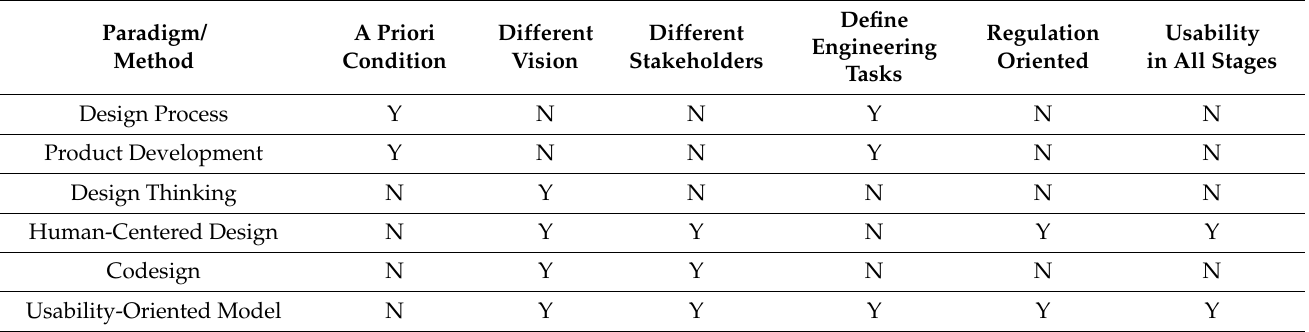
Table 6. Overview of the comparison between the usability-oriented model and the presented paradigms/models (Y: Yes, N: